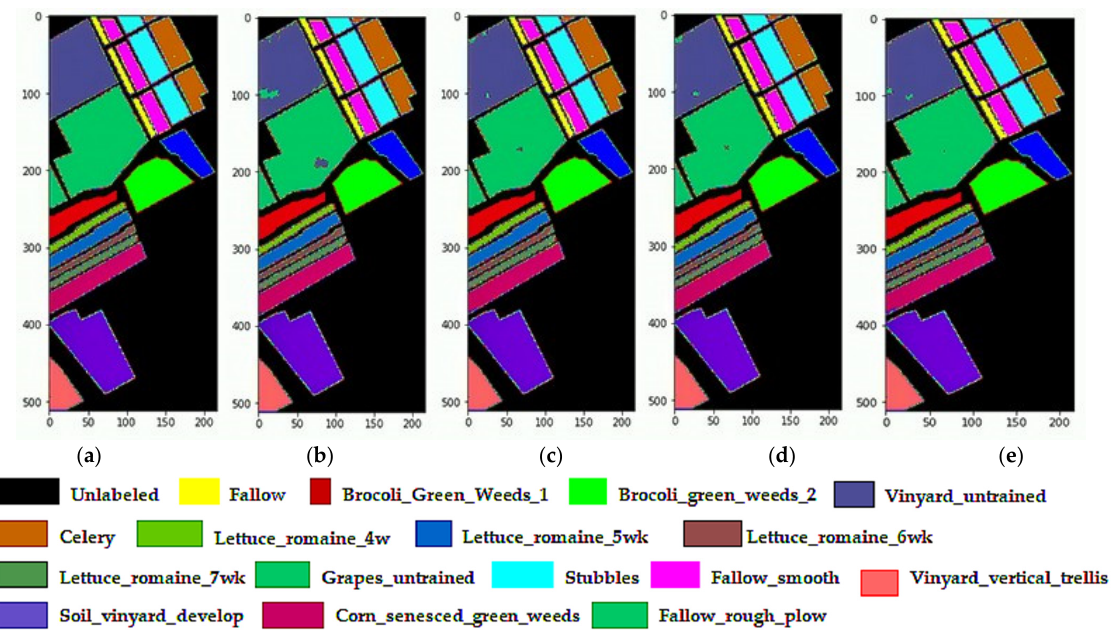
Figure 18. Classification maps of SA dataset: ( a ) Ground truth; ( b ) R-HybridSN; ( c ) HybridSN; ( d ) SSRN ( e ) HybridGBN-SR.